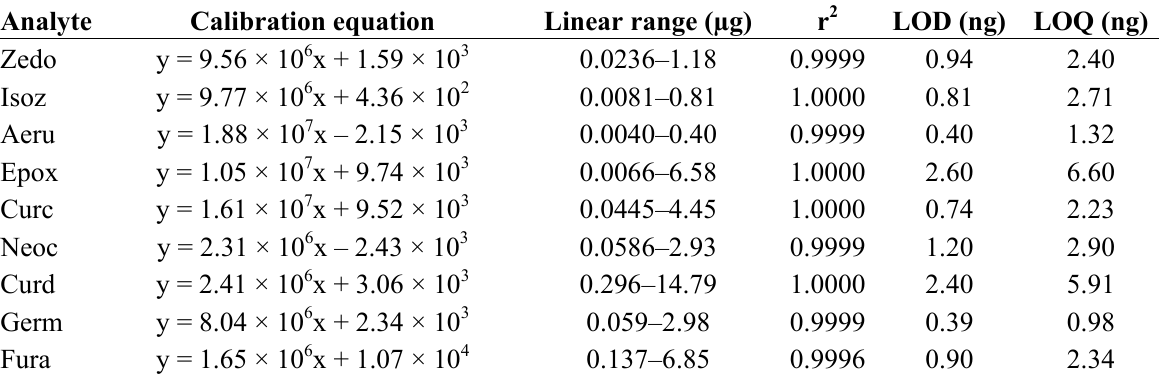
Table 1. Regression data of nine sesquiterpenes in Curcuma wenyujin at 244 nm.